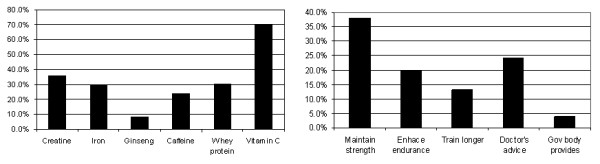
Supplements used and performance-related reasons for use by respondents who take supplements (n = 520), expressed as percentage of the sample. Respondents could select more than one reason or supplement thus the accumulated % exceeds 100%.